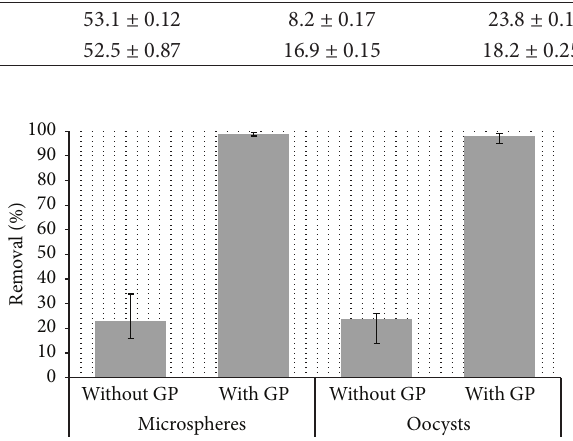
Figure 1: Experimental setup (100g gangue powder was added). Figure 2: Cryptosporidium -sized microspheres (1.8 #/mL) and Cryptosporidium oocysts (1.8#/mL) removal by active carbon car- tridge filter with and without gangue powder